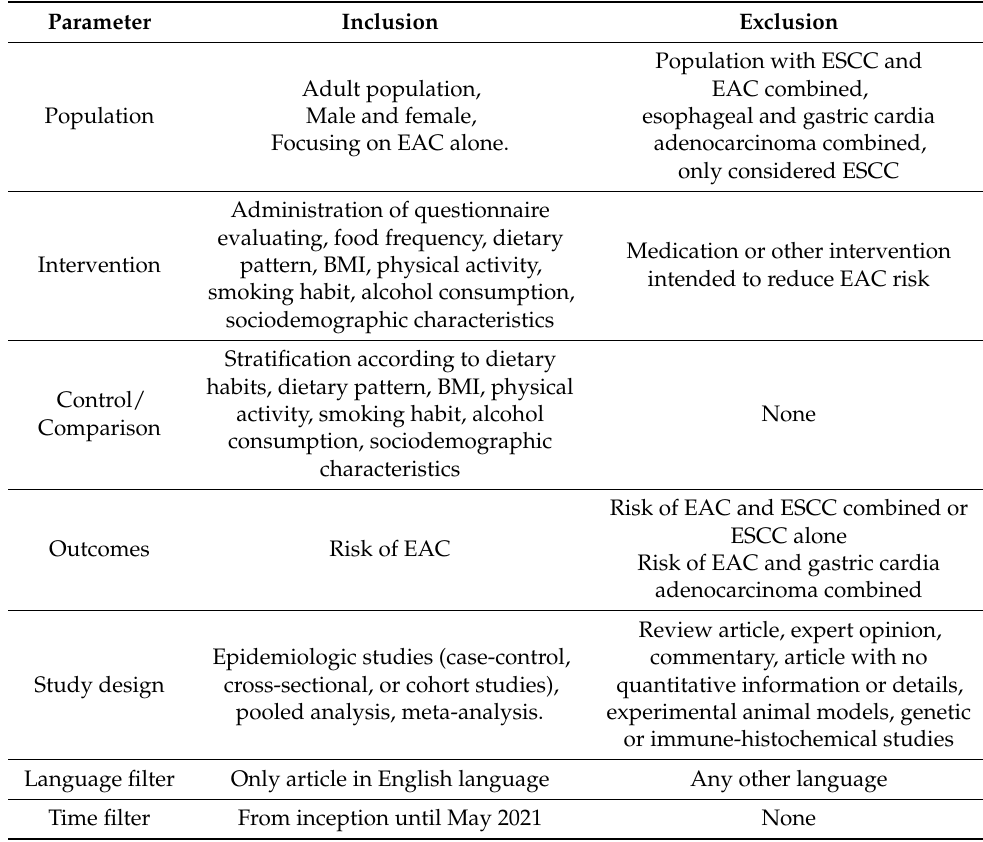
Table 1. Inclusion and exclusion criteria for the studies’ review combining the PICOS